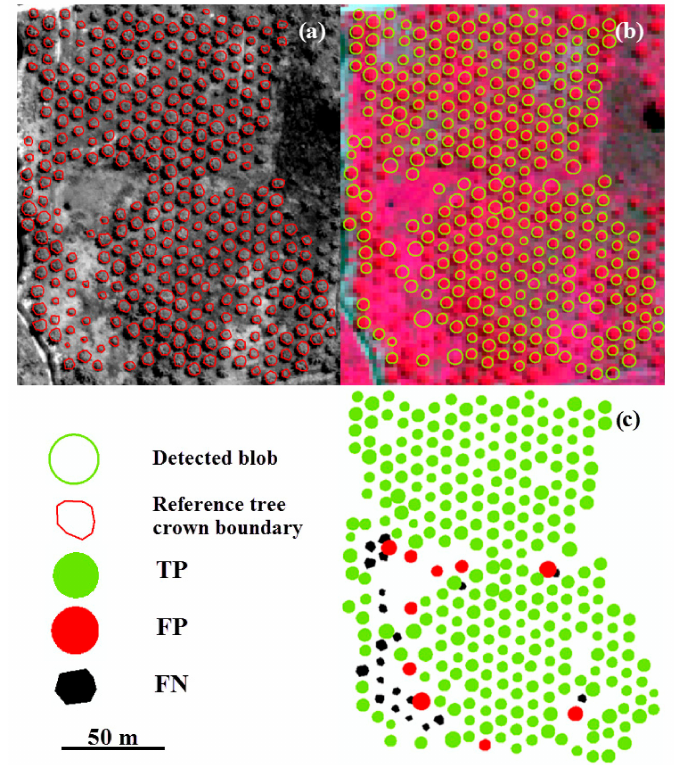
Figure 8. Results of tree detection in discrete Gaussian scale space with modified tree size measurements using f 3 ( s ). ( a ) Reference data from a panchromatic image; ( b ) The oil palm orchard with detected blobs; ( c ) The error map.